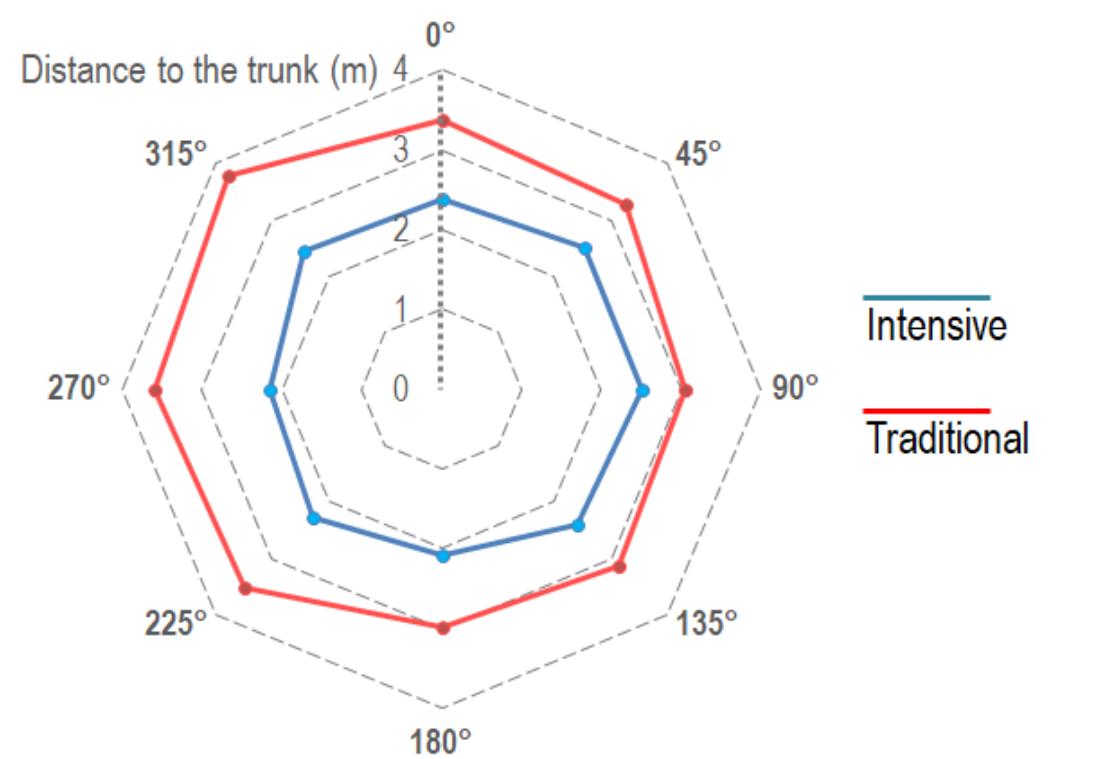
Figure 6. Mean value for the 8 radii of the tree crown in the two cultivation systems studied.